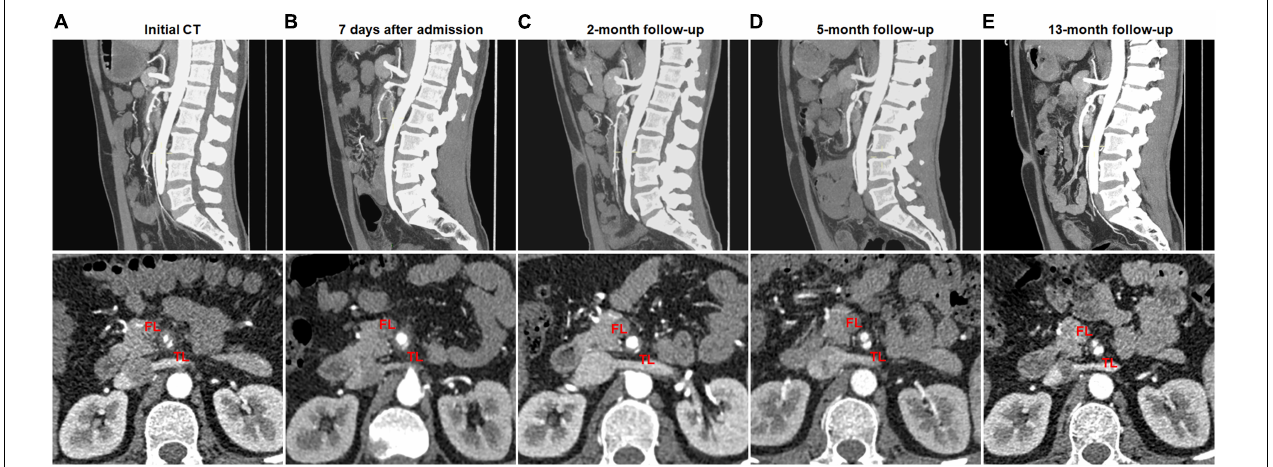
FIGURE 4 | Partial remodeling of type II spontaneous isolated superior mesenteric artery dissection on follow-up computed tomography (CT) angiography. (A) Initial CT angiography showed the patent “cul-de-sac” shaped false lumen without re-entry in a 43-year-old man. (B,C) One week and 2 months after conservative treatment, the false lumen was dilated and severely compress the true lumen. (D,E) Five and 13 months later, the false lumen was progressively reduced, and the true lumen was partially recanalized.